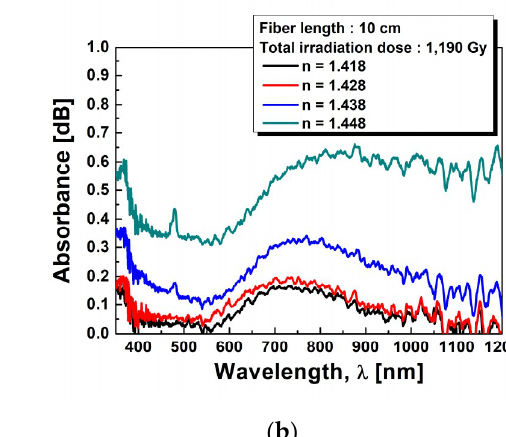
Figure 4. ( a ) Refractive index difference and ( b ) stress profile of the fiber before and after the γ -ray irradiation with the dose rate of 3570 Gy.